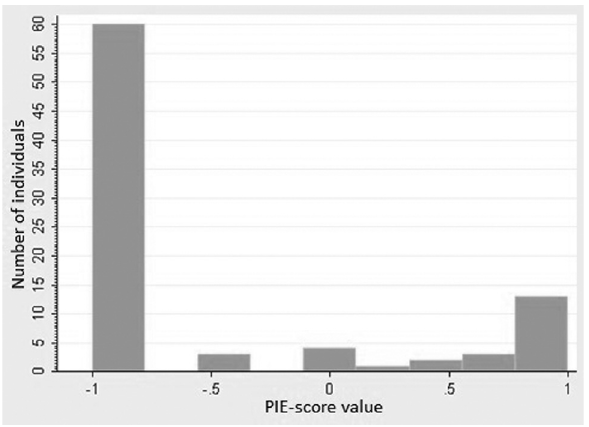
Figure 1 - Histogram of distribution of iris color variation. X axis: PIE-score (Pixel Index of the Eye) ranged from -1 to 1 (i.e. from brown to blue, respectively). Y axis: Number of individuals with each PIE-score